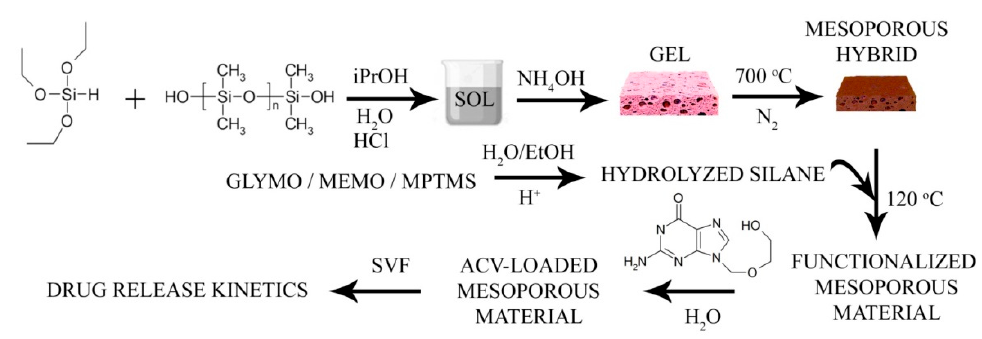
Figure 1. Schematic representation of the synthesis of the mesoporous material, functionalization with the silane molecules, and the drug loading and release procedures.